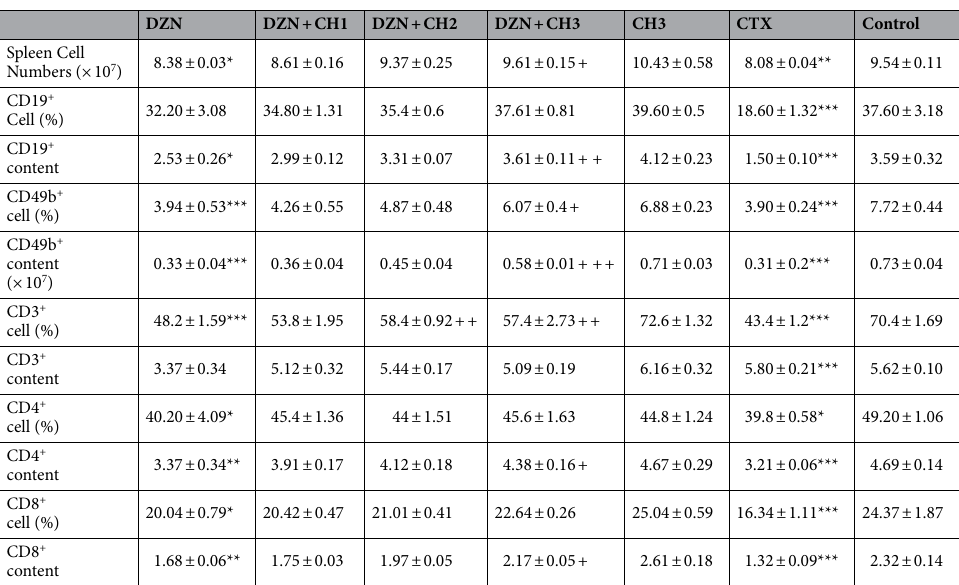
Table 1. The results of DZN 20 mg/kg and CH 50 mg/kg, and DZN plus CH (12.5, 25, and 50 mg/kg) on splenocyte subtypes in BALB/c mice. Data showed as mean ± SD, (*) showed significant effect compared to control, ( +) comparison with the diazinon-treated group. p < 0.05 and (***) or (+ + + +) p < 0.001. DZN caused a significant reduction in the percentage and number of TCD4 + , TCD8 + , and NK cells. However, in the presence of CH, it could somehow neutralise the effect of DZN and increase the percentage and the number of immune